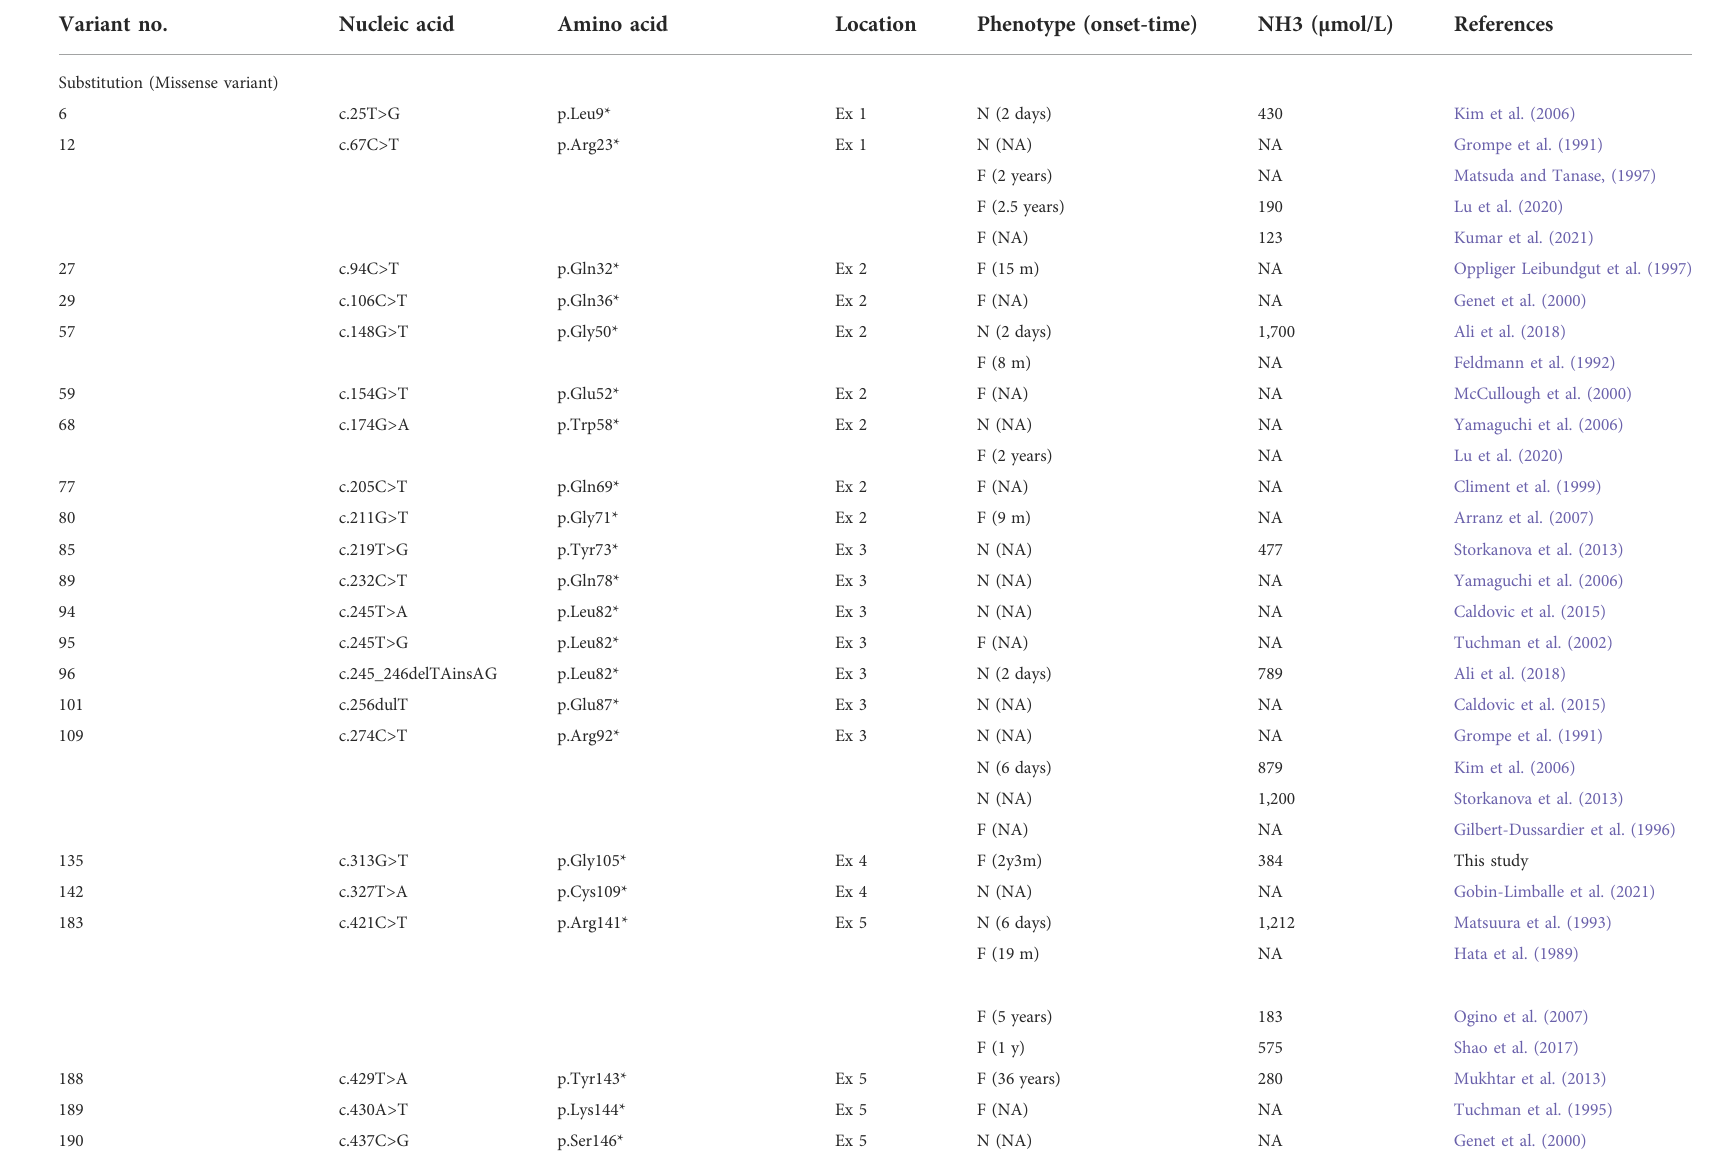
TABLE 1 Variants in the OTC gene and phenotype. Variant